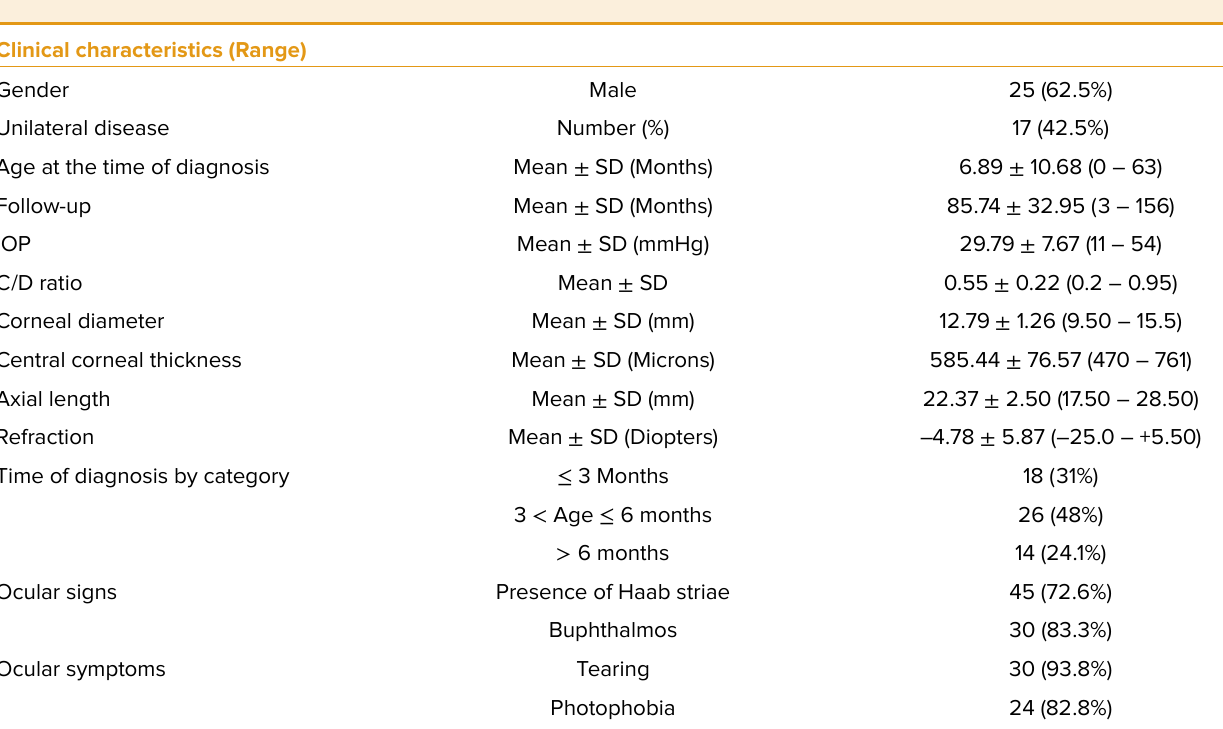
Table 1. Baseline characteristics of the patients. Clinical characteristics